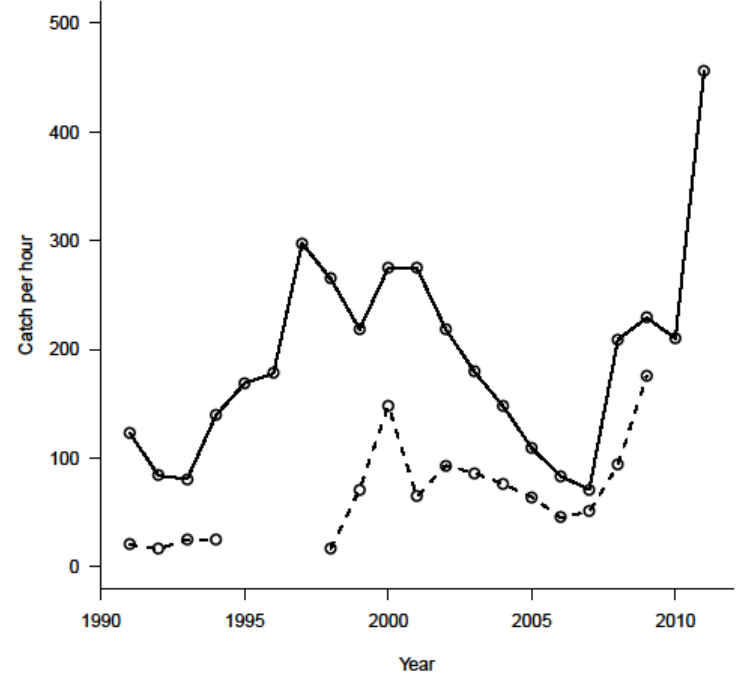
Figure A1.5. Relative abundance of Glen Canyon National Recreation Area rainbow trout (solid line) between Glen Canyon Dam and Lees Ferry, and Grand Canyon National Park rainbow trout (dashed line) between the Paria and Little Colorado River confluences with the Colorado River. Estimates are mean electrofishing catch rates from multiple sample